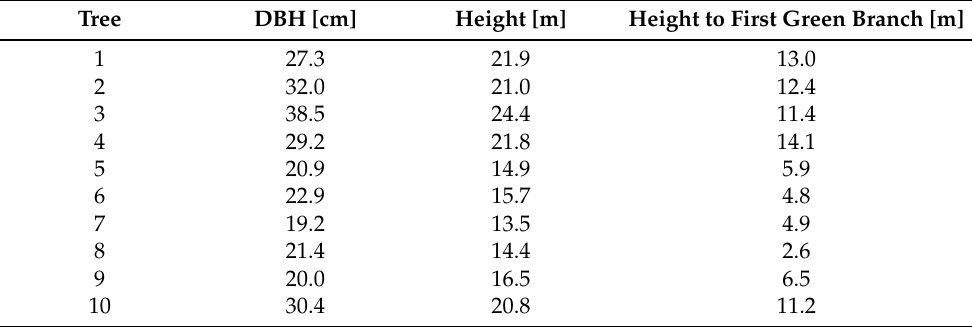
Table 1. Field-sampled trees used in the study. DBH is the stem diameter at breast height. Tree